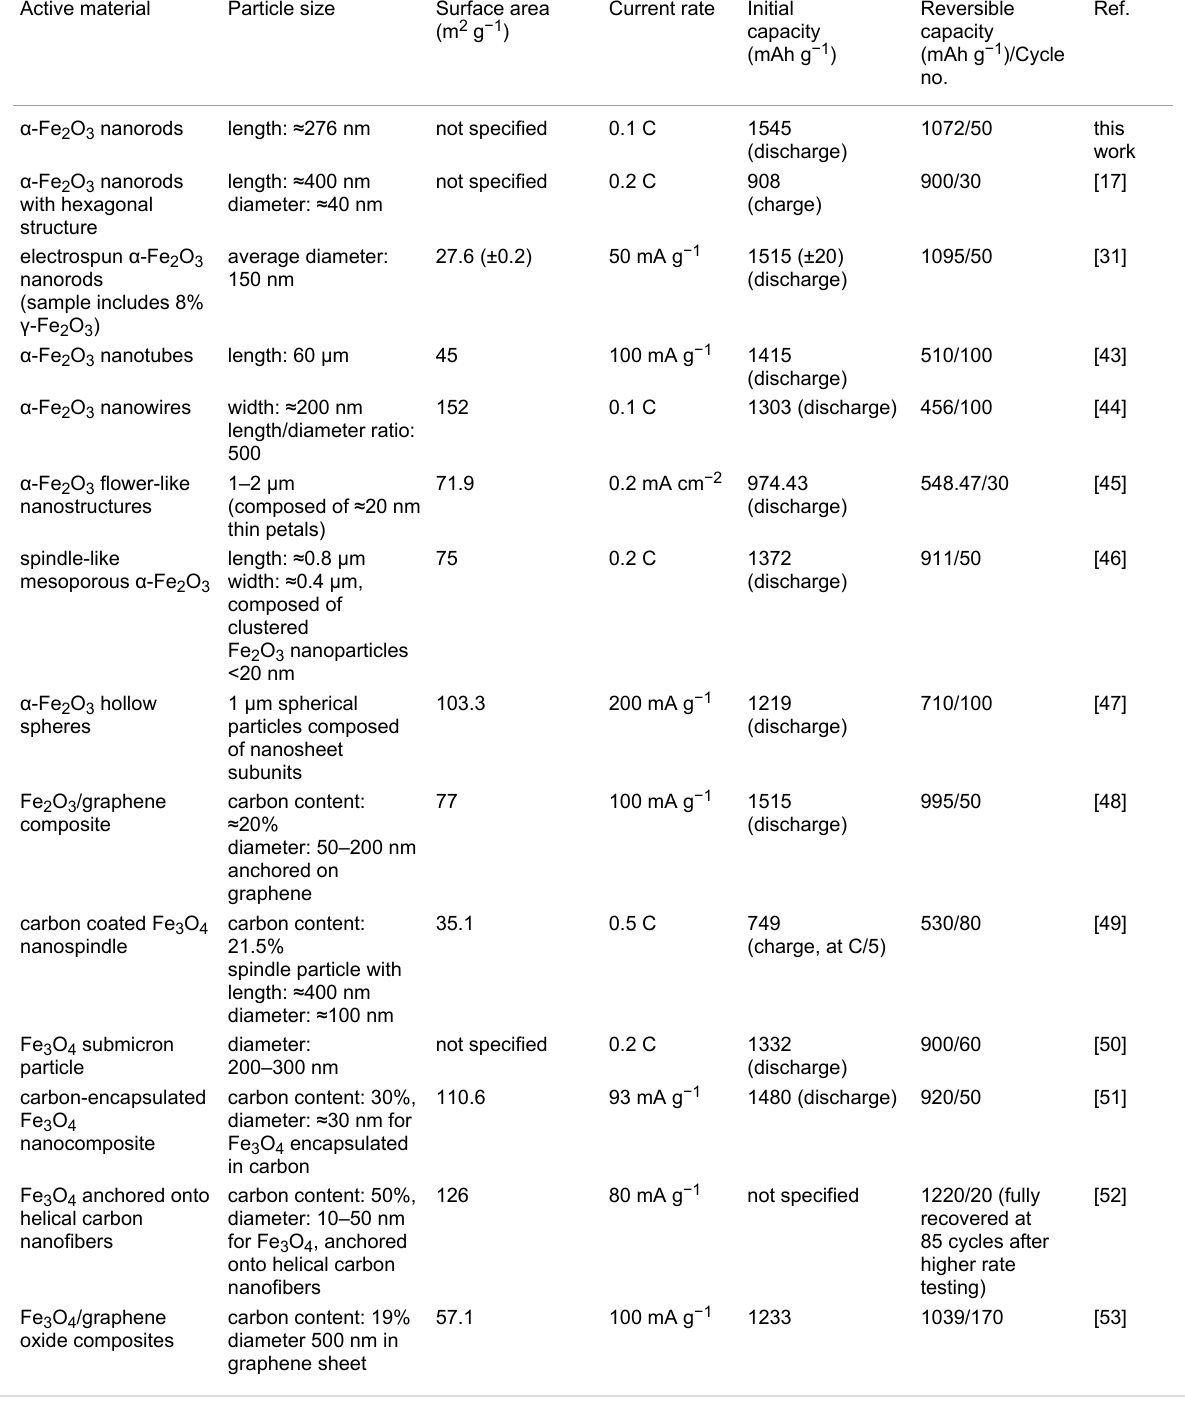
Table 3: Electrochemical performance of several α -Fe 2 O 3 nanoparticles with different morphologies. Active